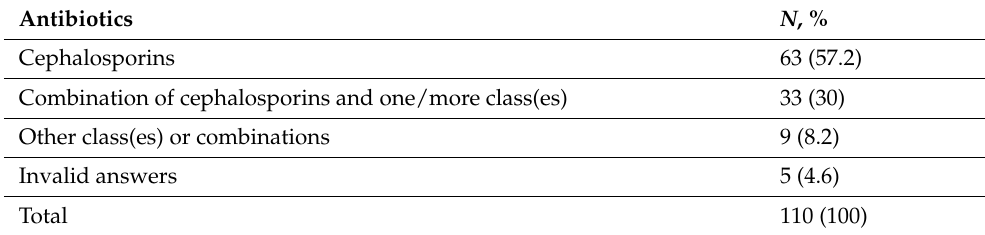
Table 4. Antibiotics-preoperative use—complicated appendicitis.